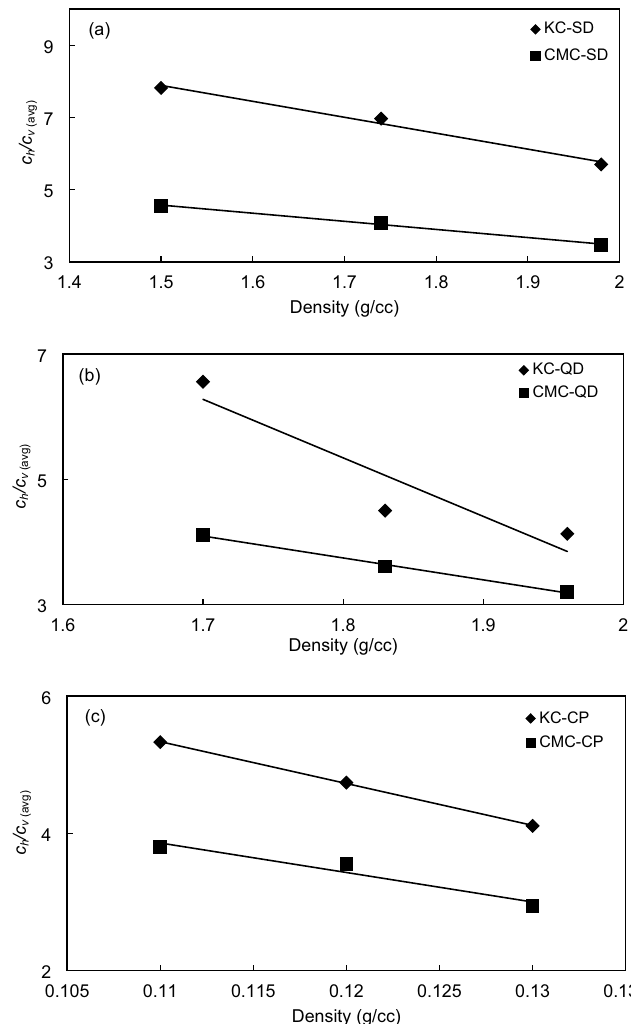
Fig. 7 c h / c v (avg) values for KC and CMC with a sand, b quarry dust, c coir pith drain at various